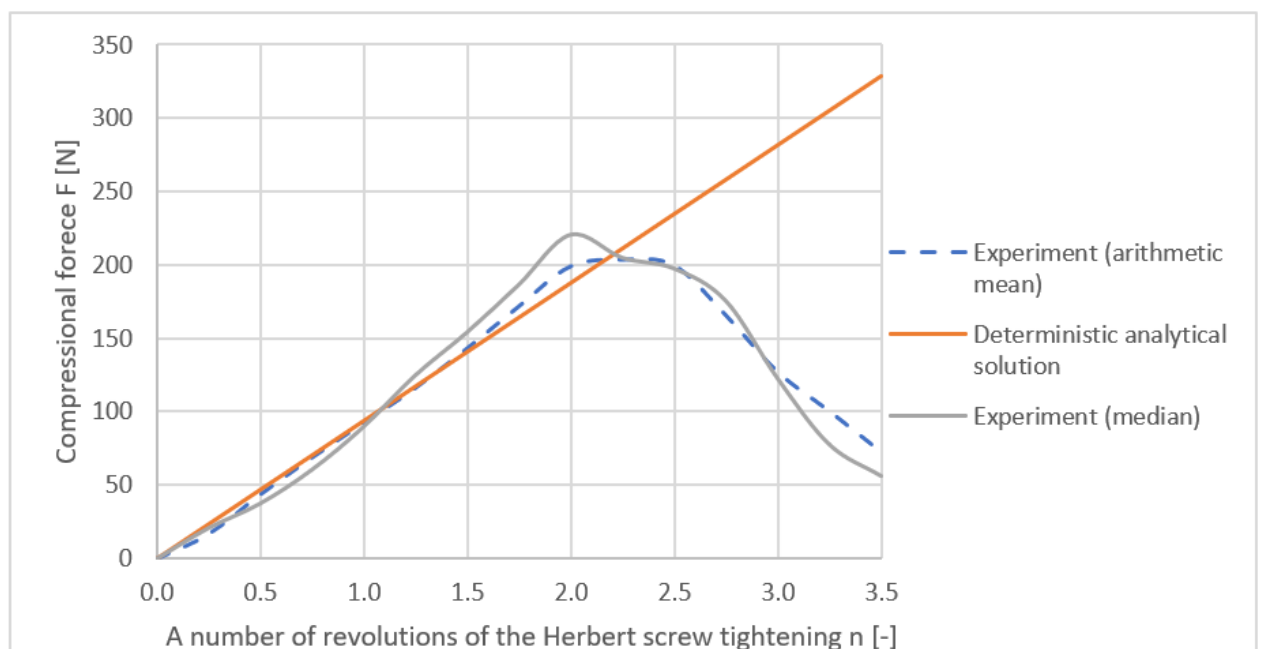
Figure 17. Comparison of methods.